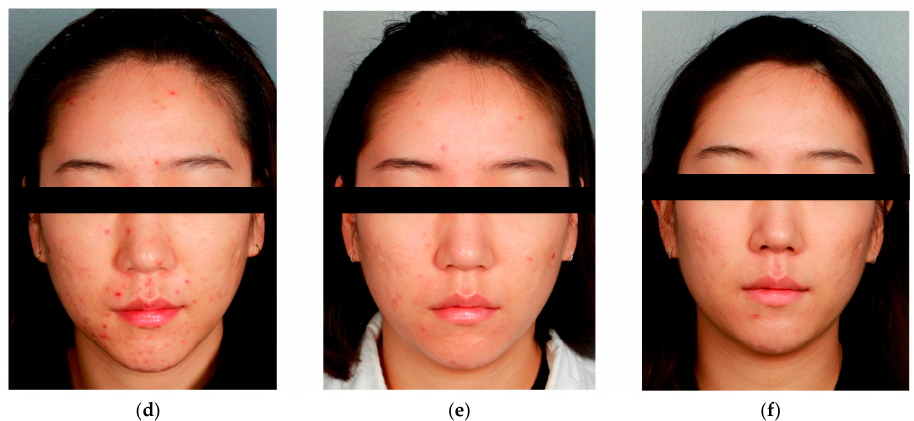
Figure 4. Examples of improved clinical photos. ( a , d ) V1 (before the first session), ( b , e ) V3 (after the second session), and ( c , f ) V4 (after the third session).